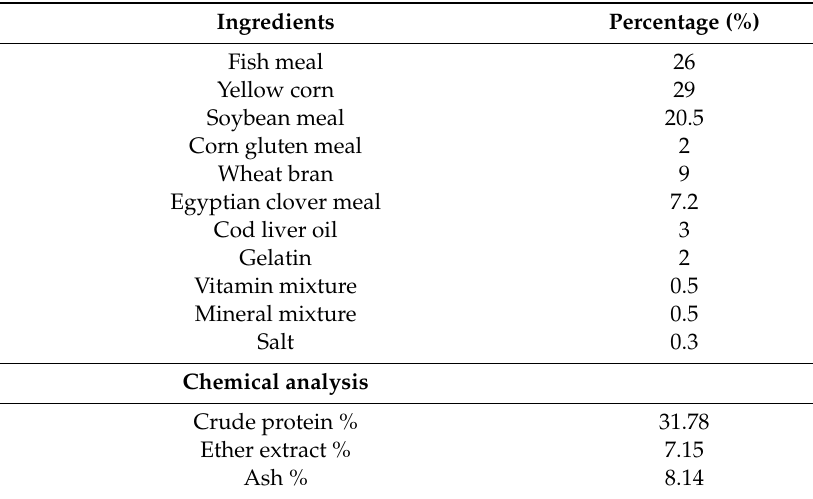
Table 1. Components and chemical analysis of the basal diet.